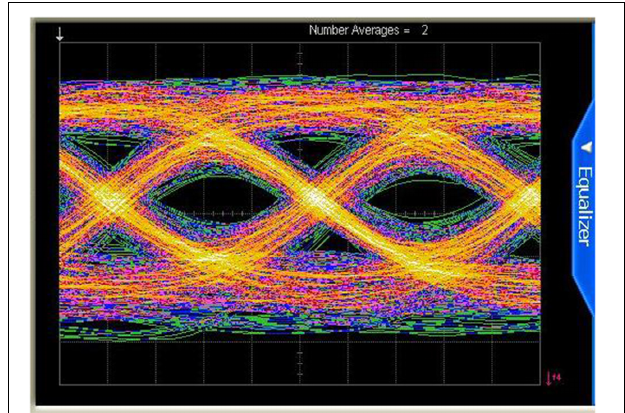
FIGURE 6 | Optical eye diagram obtained from a device with 0.5mm phase modulators at 52Gbit/s.